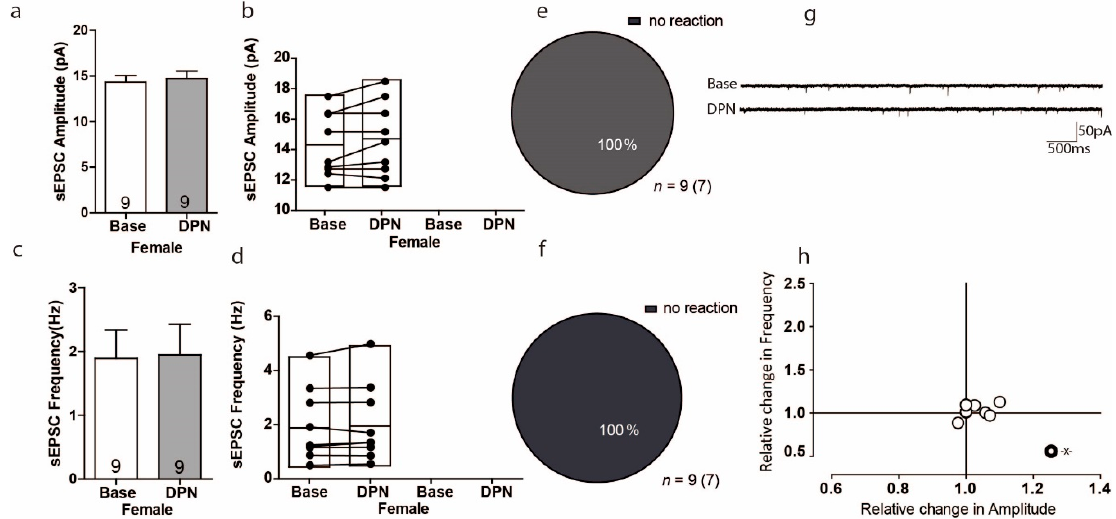
Figure 3. Activation of ERß had no influence on excitatory transmission in the PFC of female mice. ( a , c ) No significant changes were found in the average sEPSC amplitude and sEPSC frequency in mPFC during baseline and after E2 treatment. ( b , d ) Plots showing individual sEPSC amplitude responses to E2 within-cell analyses during the baseline and after E2 treatment in the same cell. ( e , f ) The proportion of cells responding to E2 treatment. ( g ) Sample traces, frequencies and amplitudes of sEPSCs before and after E2 treatment. ( h ) Plots showing the normalized change in sEPSC frequency versus amplitude for each cell.